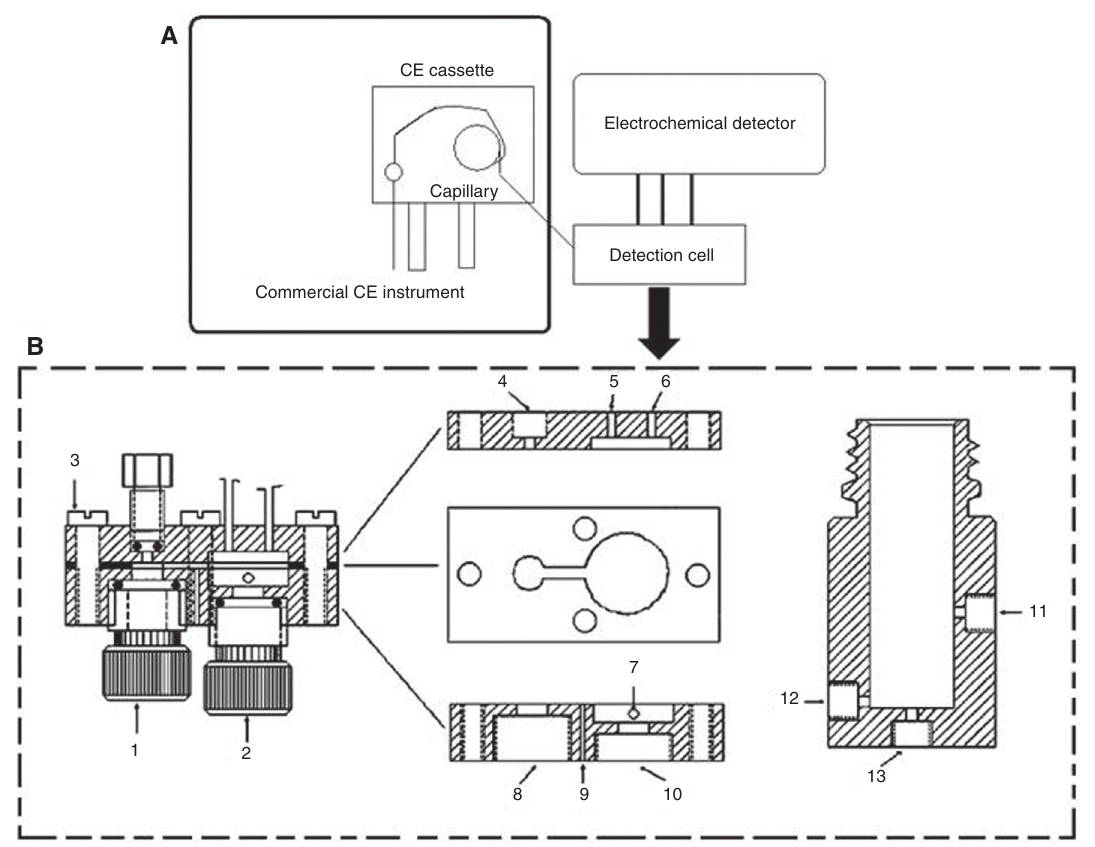
Figure 5 Scheme of (A) on-capillary ED coupled in to commercial CE instrument, (B) detection electrochemical cell and cathodic vial for commercial capillary electrophoresis system: nut adapters for (1) working and (2) reference electrodes; (3) screw; (4) connection with vial for capillary electrophoresis system; (5) vacuum connection; (6) flow outlet; (7) drain outlet; electrode holders: (8) working; (9) auxiliary; (10) reference; (11) vacuum connection; (12) drain outlet; (13) cell connection. Reproduced with permission from Elsevier [Chicharro et al.